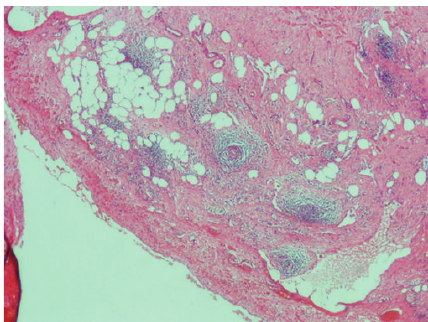
Figure 2: The cystic mass was located between the posterior border of the left sternocleidomastoid muscle and the mastoid apex.